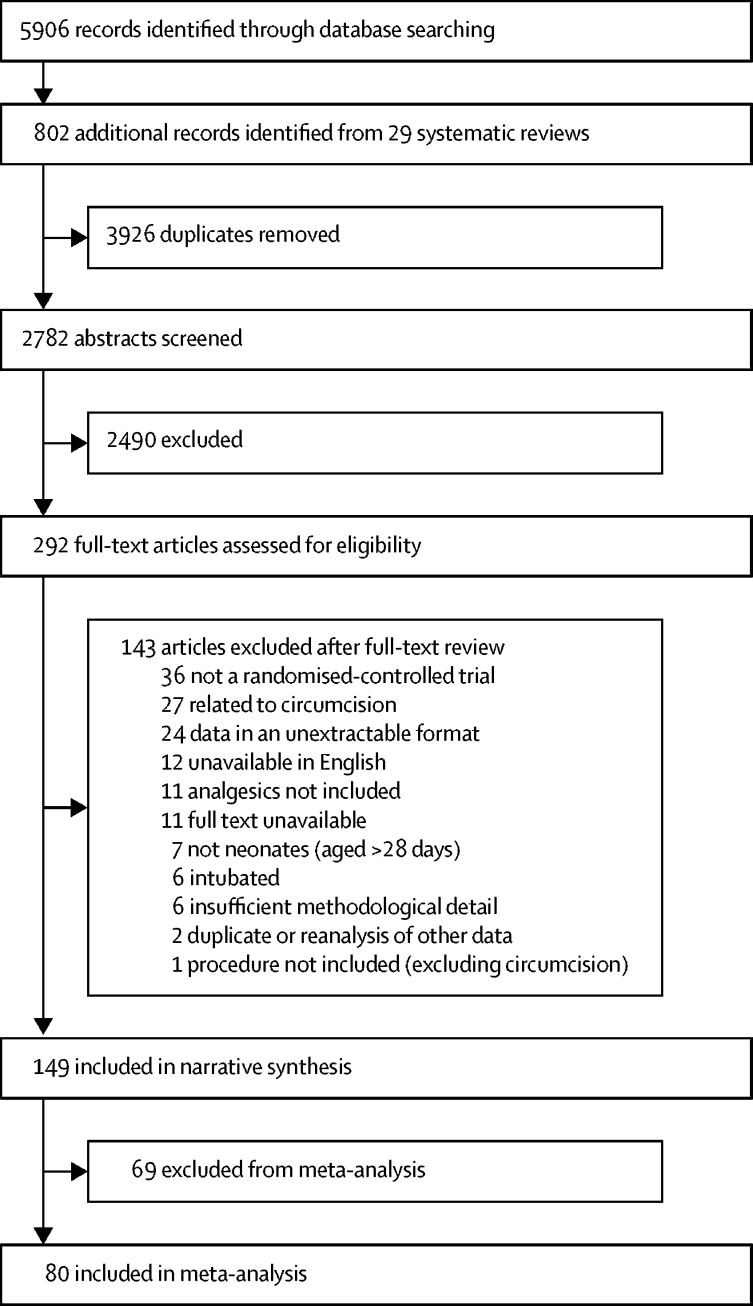
Study selection